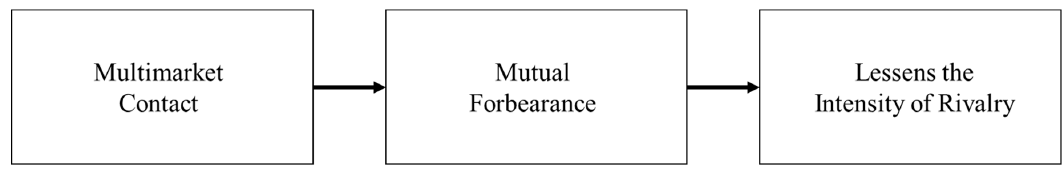
Figure 1. Traditional Framework of MMC and its Consequences. Source: Authors’ illustration based on the literature review.